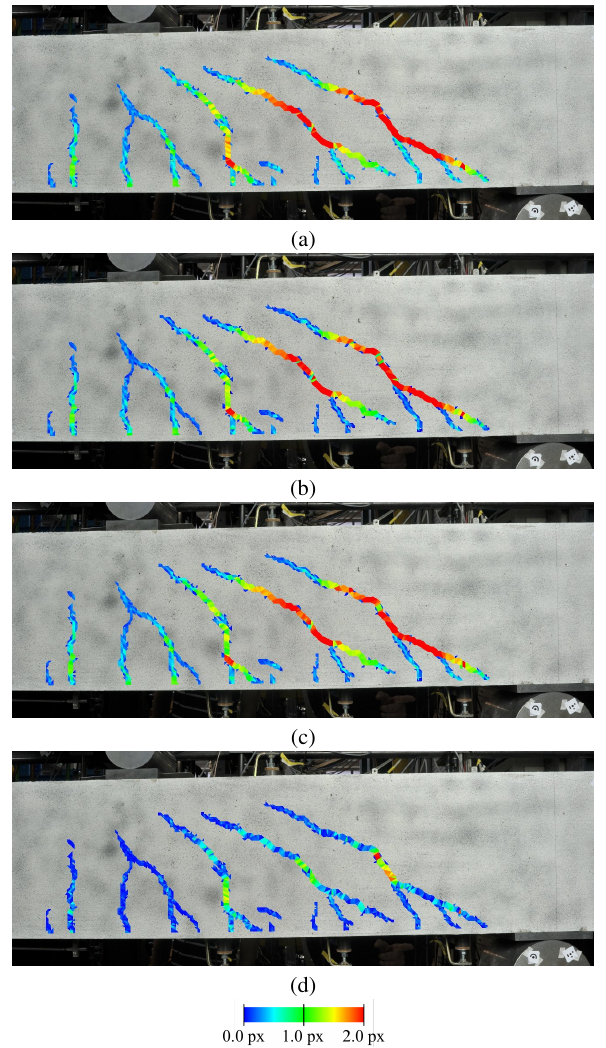
Table 4. Statistical values of the residuals to the manual measurements in px without outliers